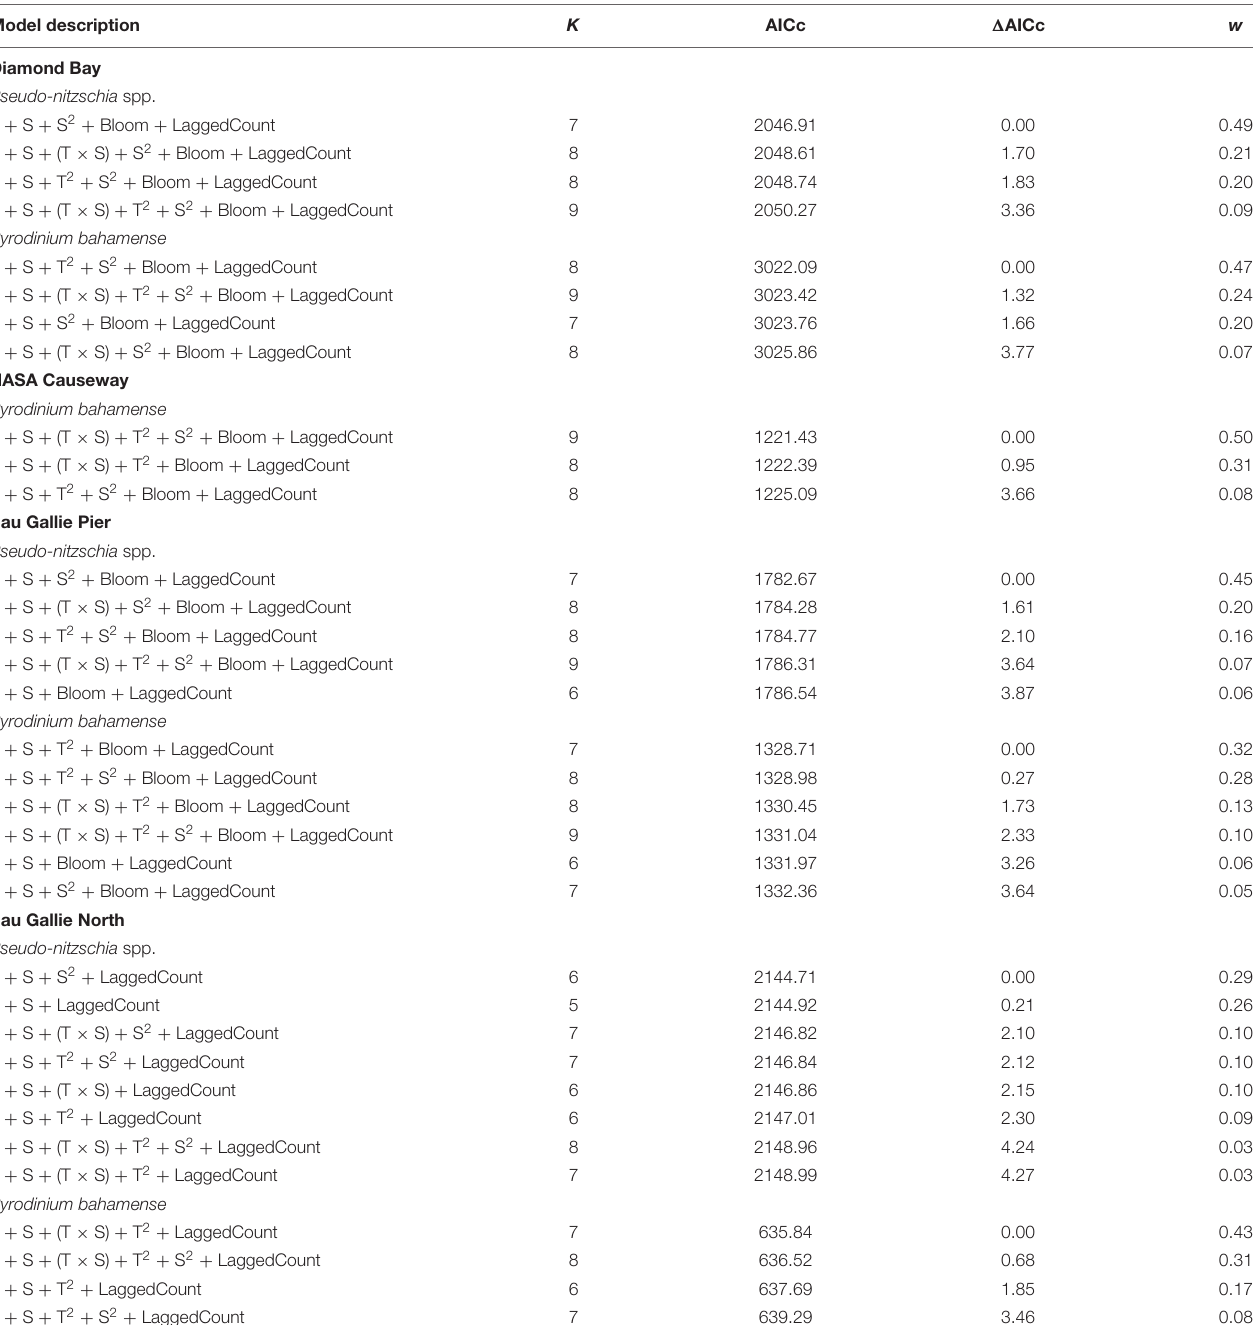
TABLE 3 | Model parameters, number of parameters (K), AICc, (cid:49) AICc, and AICc weights ( w ) for the candidate set of negative binomial regression models relating weekly Pseudo-nitzschia spp. and Pyrodinium bahamense cell counts to temperature (T), salinity (S), the presence of an Aureoumbra lagunensis bloom (Bloom), and a lagged cell count (lagged by 1 week; LaggedCount) at Diamond Bay, NASA Causeway, Eau Gallie Pier, and Eau Gallie North monitoring stations. Model description K